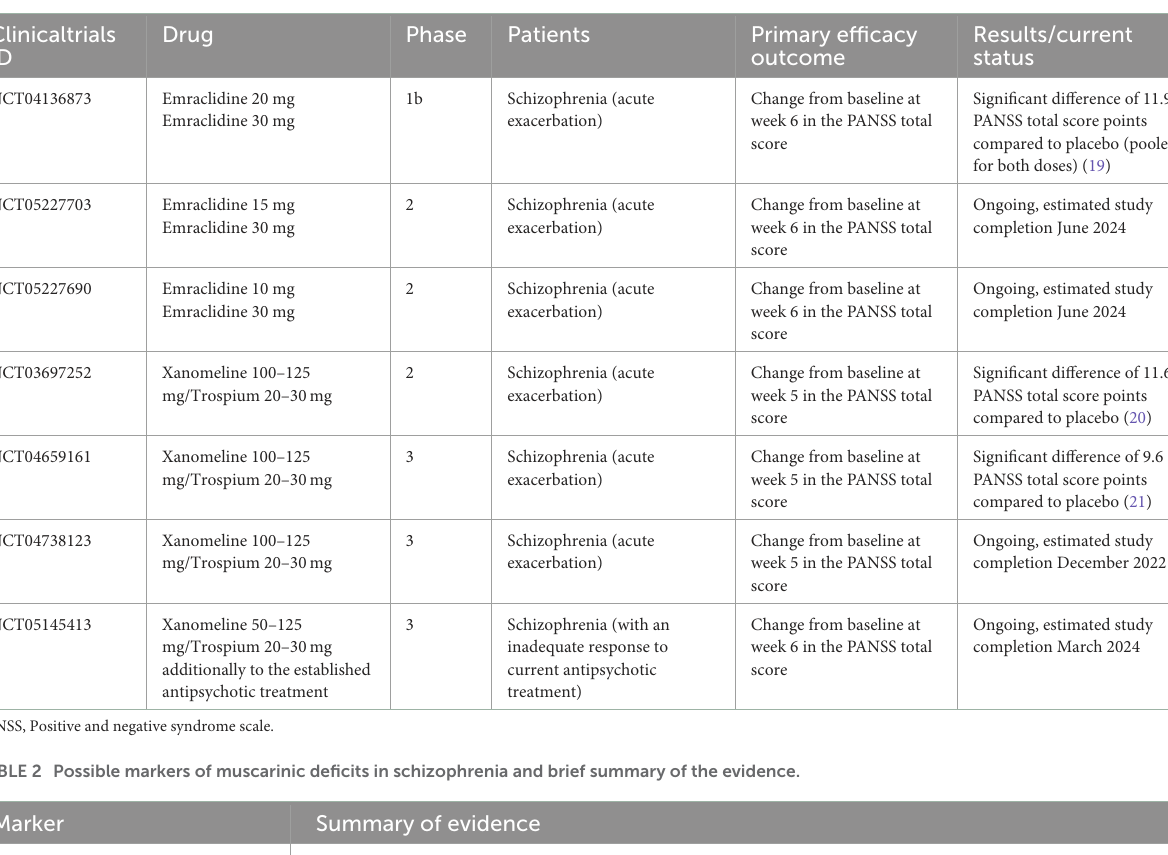
TABLE 1 Ongoing and completed trials of clinical efficacy of muscarinergic drugs in schizophrenia.